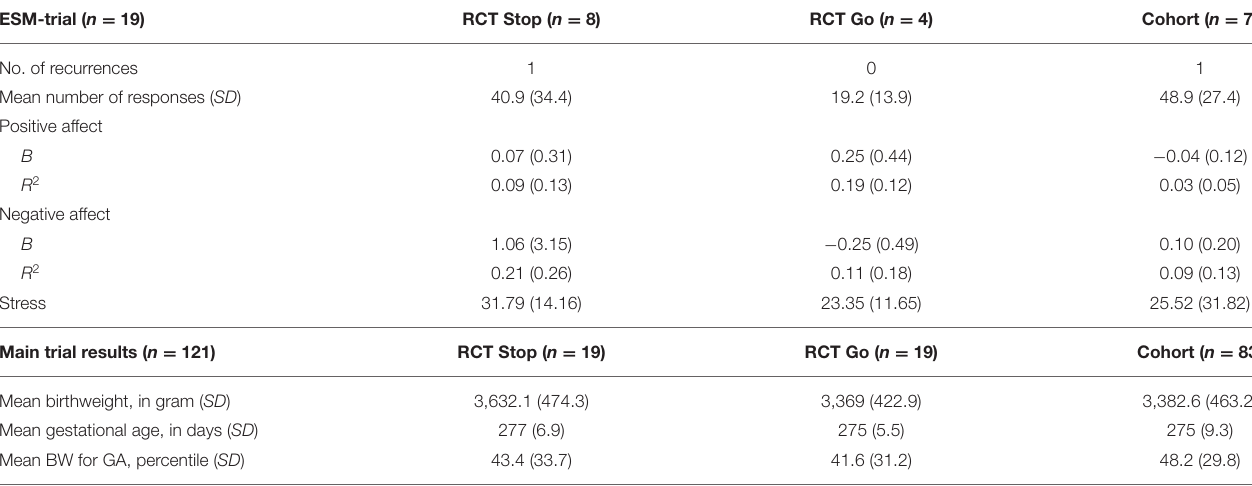
TABLE 2 | Group results follow-up measurements and